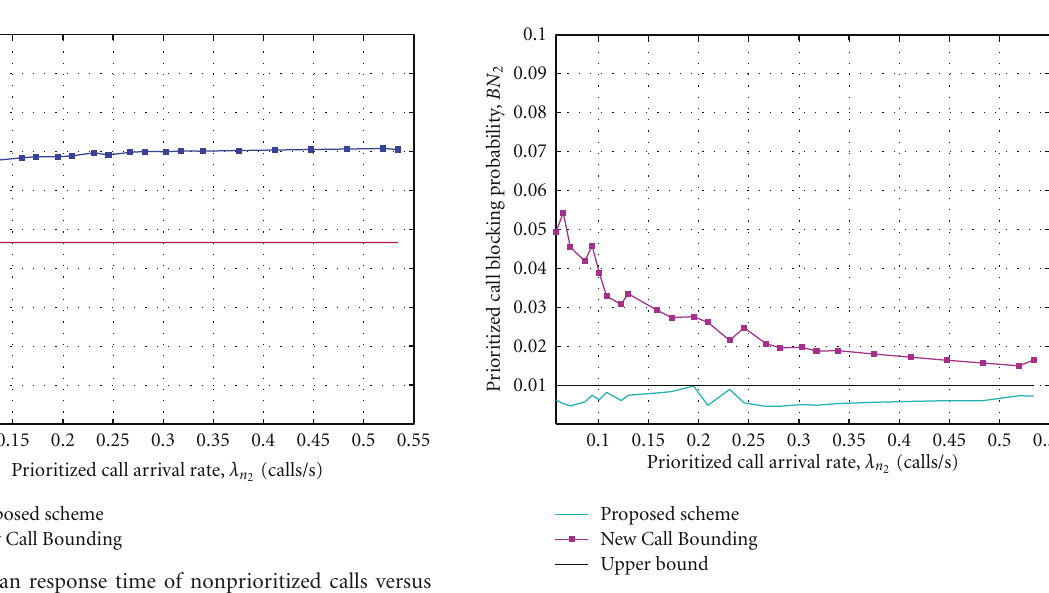
Figure 4: Prioritized call blocking probability versus prioritized calls arrival rate.